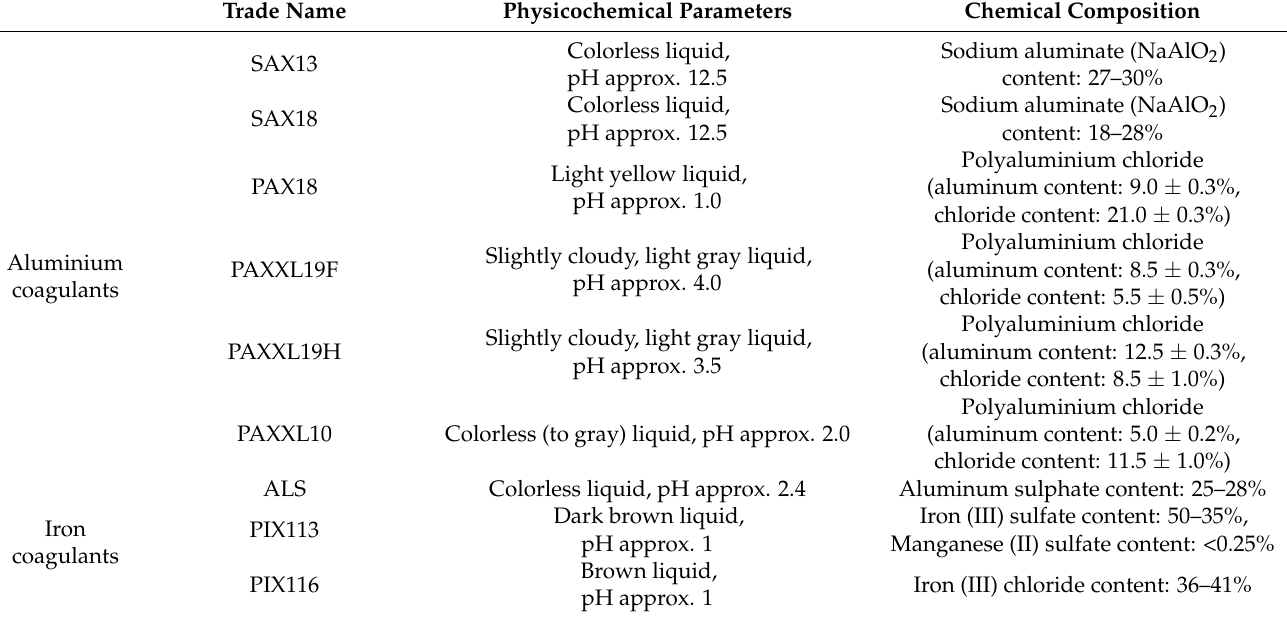
Table A1. Characteristics of the tested